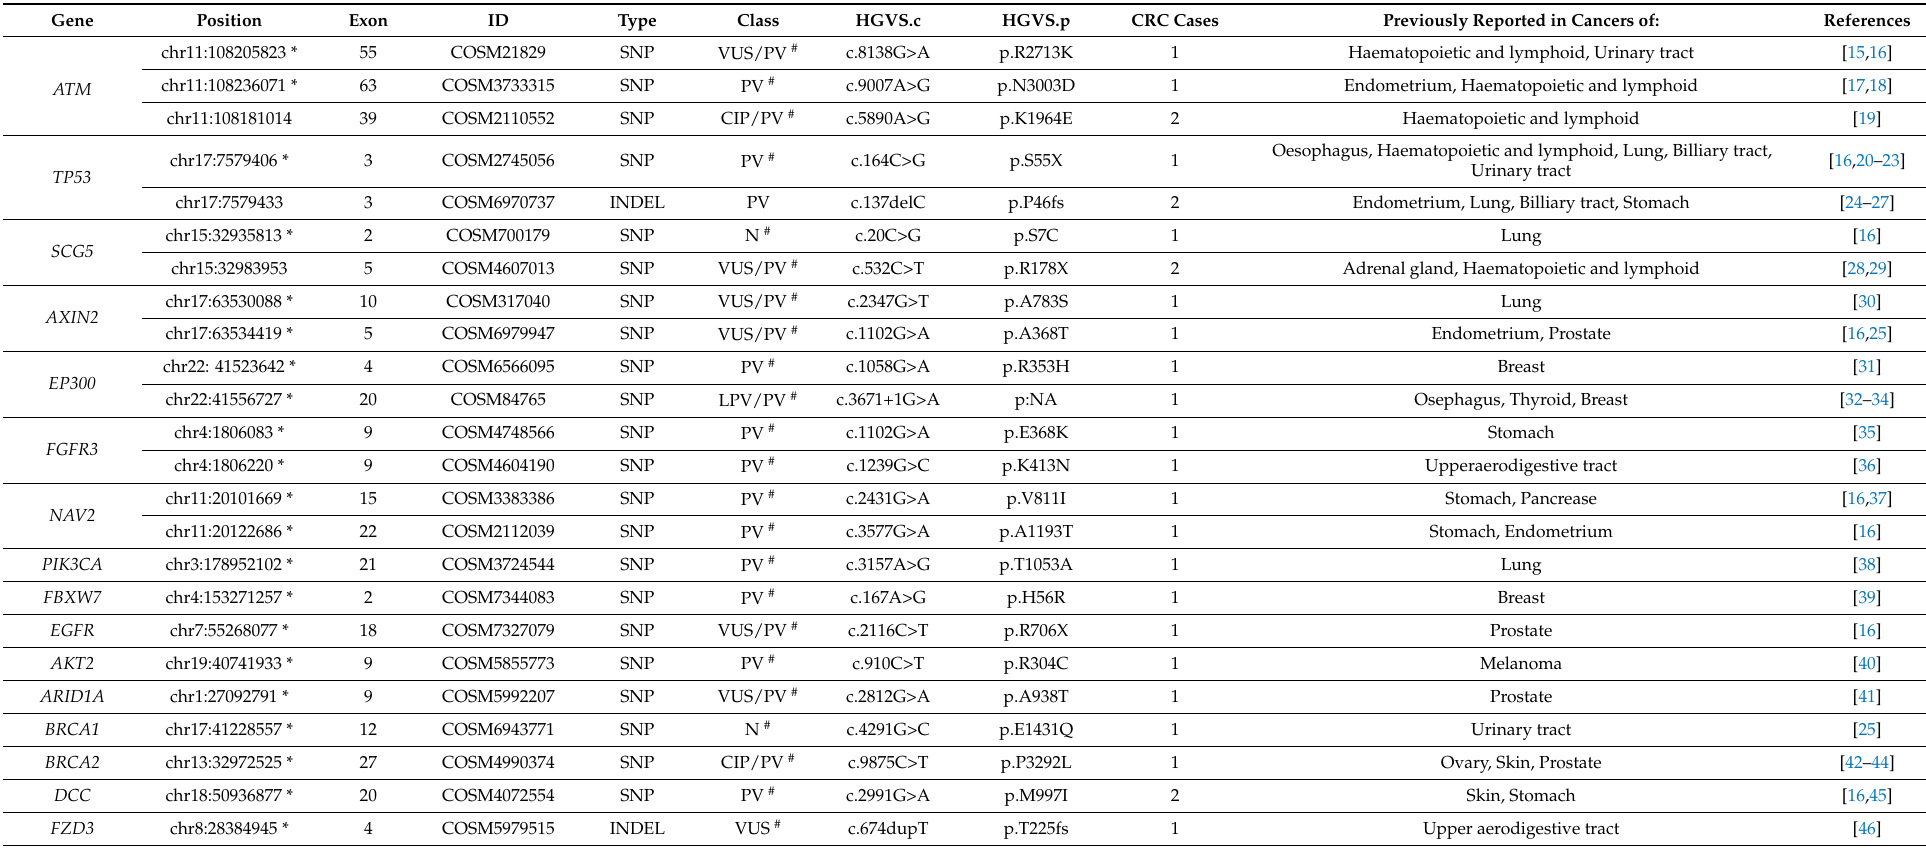
Table 2. The identified somatic variants that were not previously addressed in colorectal